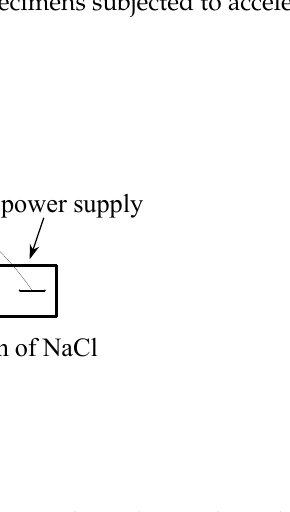
Figure 2. Configuration of specimens subjected to accelerated corrosion.